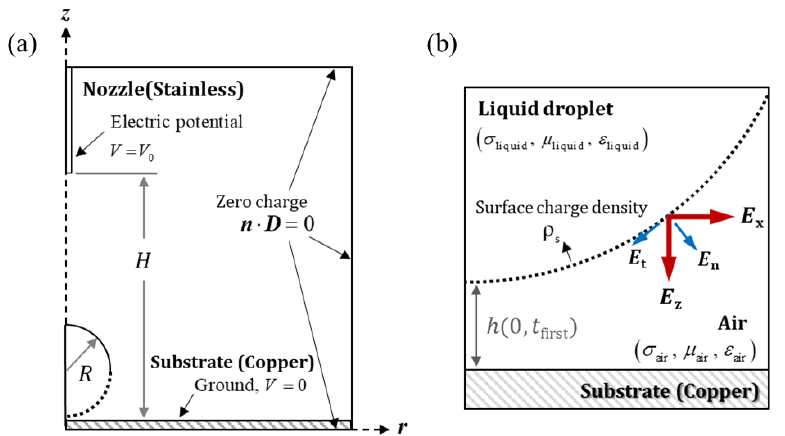
Figure 2. A schematic of boundary conditions for the electrostatic simulation. ( a ) all domain and ( b ) the specified domains nearby the electrified droplet.